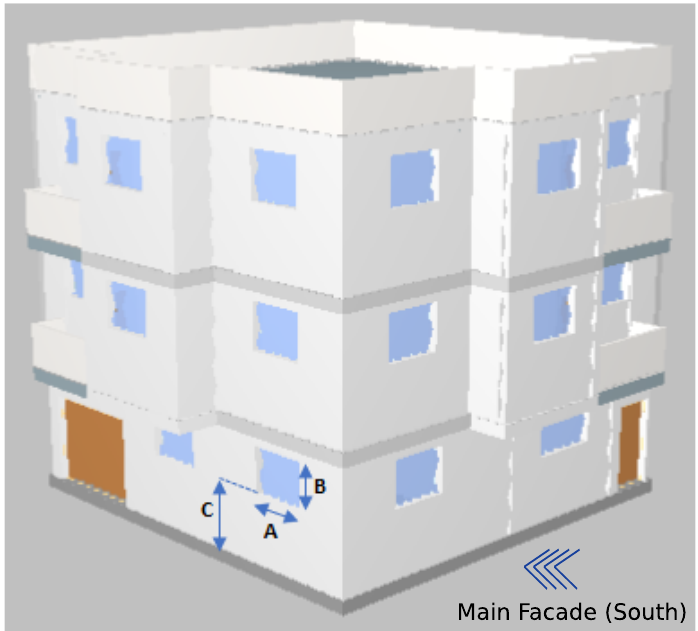
Figure 8. Case study: general overview and window dimensions (A = 1.35 m, B = 1.10 m, C = 1